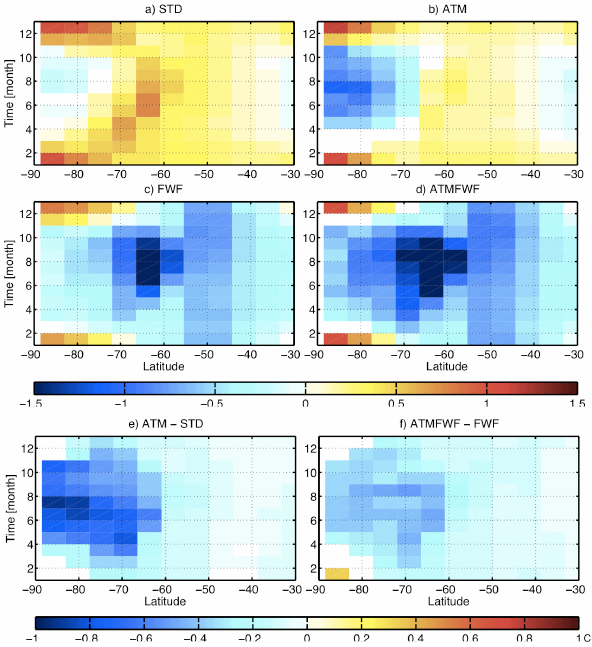
Figure 5: Zonal mean temperature differences in °C between 8 and 10 ka (8 ka minus 10 ka) 2 Fig. 5. Zonal mean temperature differences in ◦ C between 8 and for STD (a), ATM (b), FWF (c), ATMFWF (d). The difference between the data presented in 3 10ka (8ka minus 10ka) for STD (a) , ATM (b) , FWF (c) , ATMFWF panels b and a (d and c) is plotted on panel e (and f). Labels on the y-axis correspond to the 4 (d) . The difference between the data presented in panels (b) and beginning of the month. Colored areas correspond to differences significant at the 99% level 5 (a) ( d and c ) is plotted on panel (e) (and f ). Labels on the y-axis according to a Student test. Note the different color bar for upper panels (a, b, c and d) and 6 correspond to the beginning of the month. Colored areas correspond lower panels (e and f). 7 to differences significant at the 99% level according to a Student t test. Note the different color bar for upper panels ( a , b , c and d ) and lower panels ( e and f ).